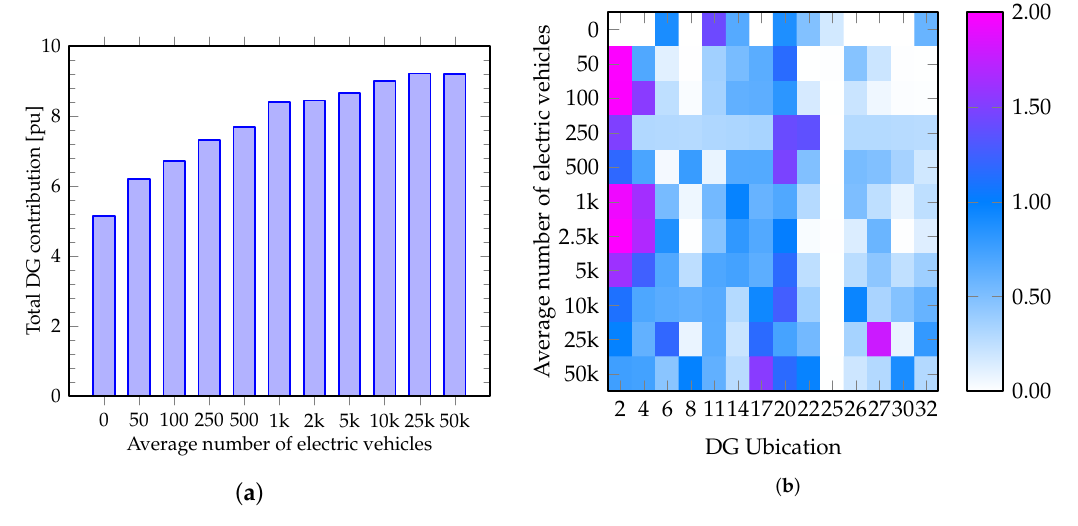
Figure 8. HC evaluation considering different penetration of EVs in the 33-bus DC grid. The shades range from white to magenta, with white being 0 pu and magenta being 2 pu. ( a ) DG Contrubition; ( b ) Color map of DG